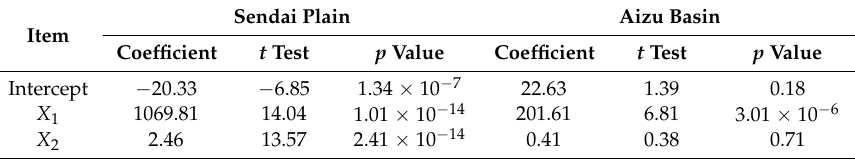
Table 2. Results of the multiple regression analysis. X 1 and X 2 denote average groundwater flow velocity and average subsurface temperature, respectively.